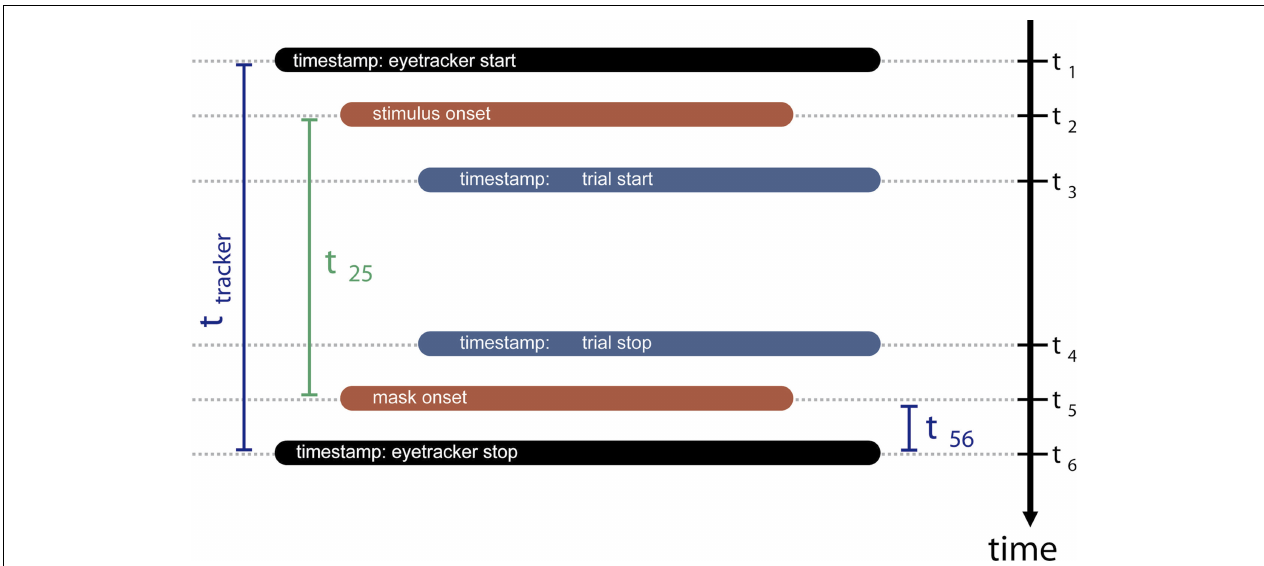
FIGURE 3 | Illustration of the procedure used to match the recorded eye movement data with the stimulus presentation timing. The goal is to determine the gaze position at the instant when the search screen was replaced by the mask. The stimulus presentation computer sends timestamps throughout the trial to the eye tracking system. Of interest is the exact delay ( t